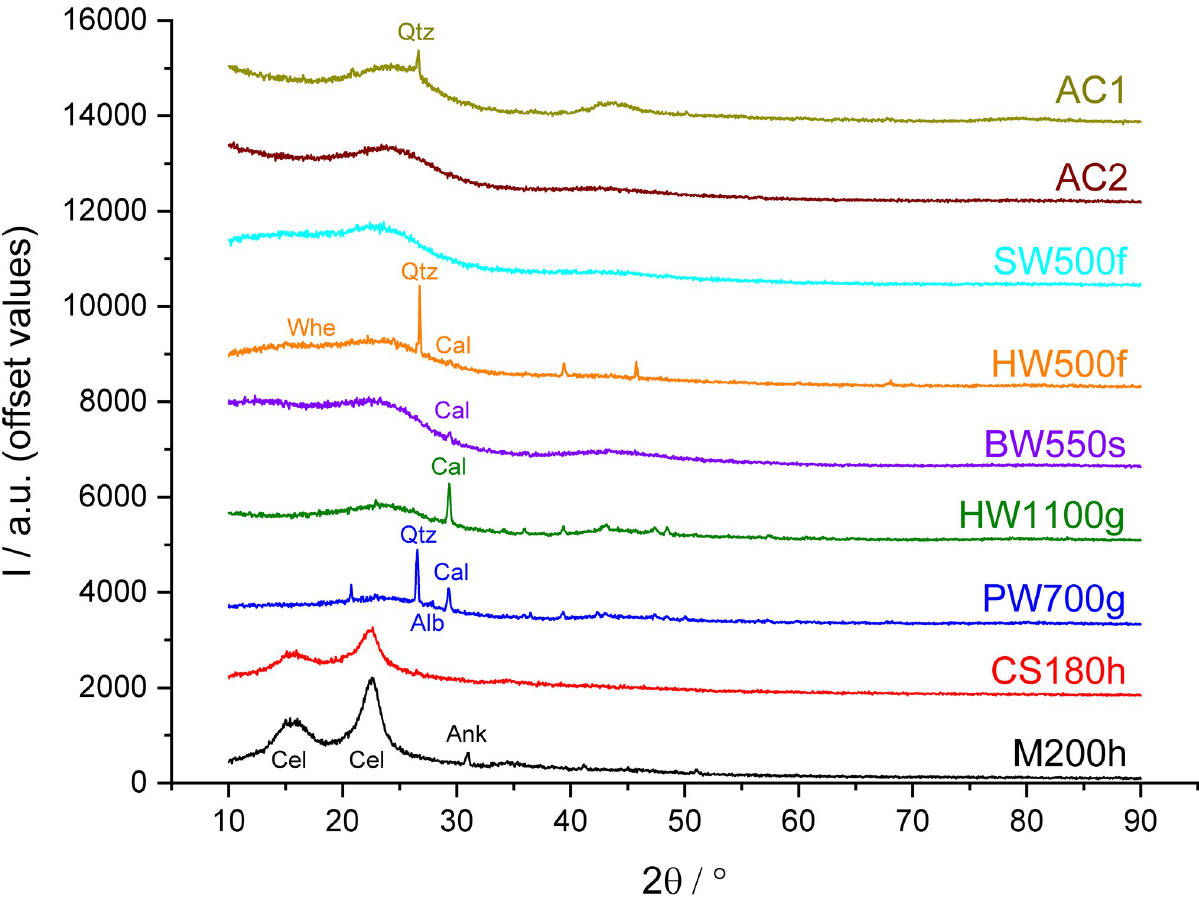
Fig 3. X-ray diffractograms of the